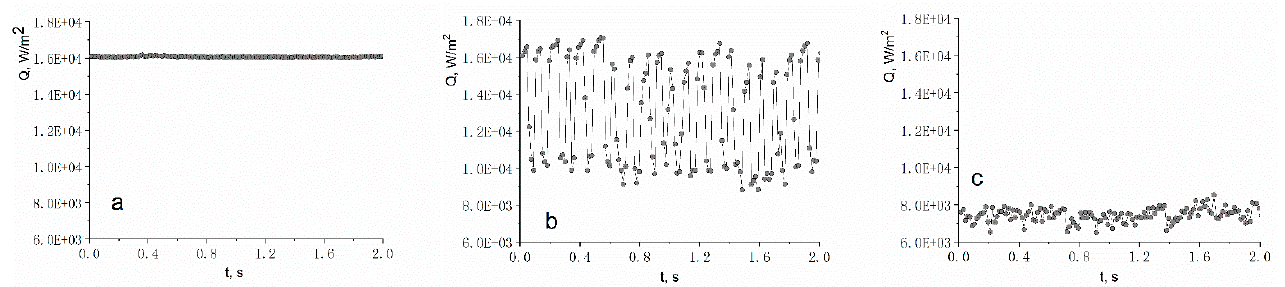
Figure 5. Heat transfer on a flat surface of an impinging inert jet: time series for the heat flux at the plate stagnation point for different Re . The flow regime at the tube outlet: ( a ) laminar— Re = 2380, ( b ) transitional— Re = 3220, ( c ) turbulent— Re = 3790.